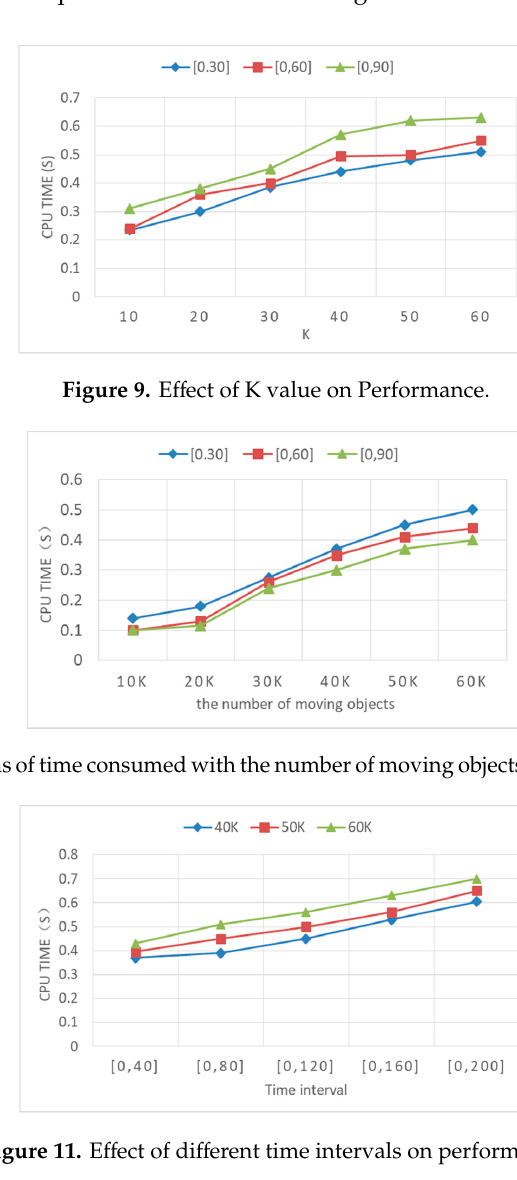
Figure 13. Effect of different time intervals on performance.